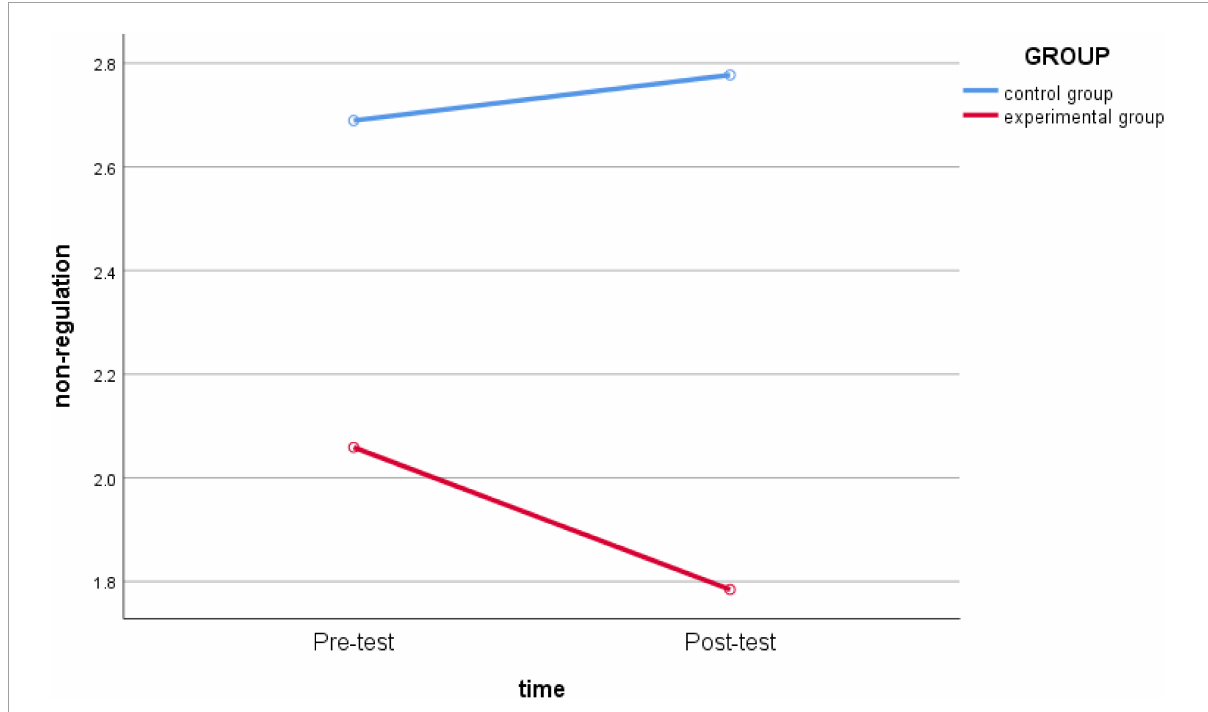
FIGURE2 Schematic diagram of the changes in non-regulation between the experimental group and the control group before and after intervention.